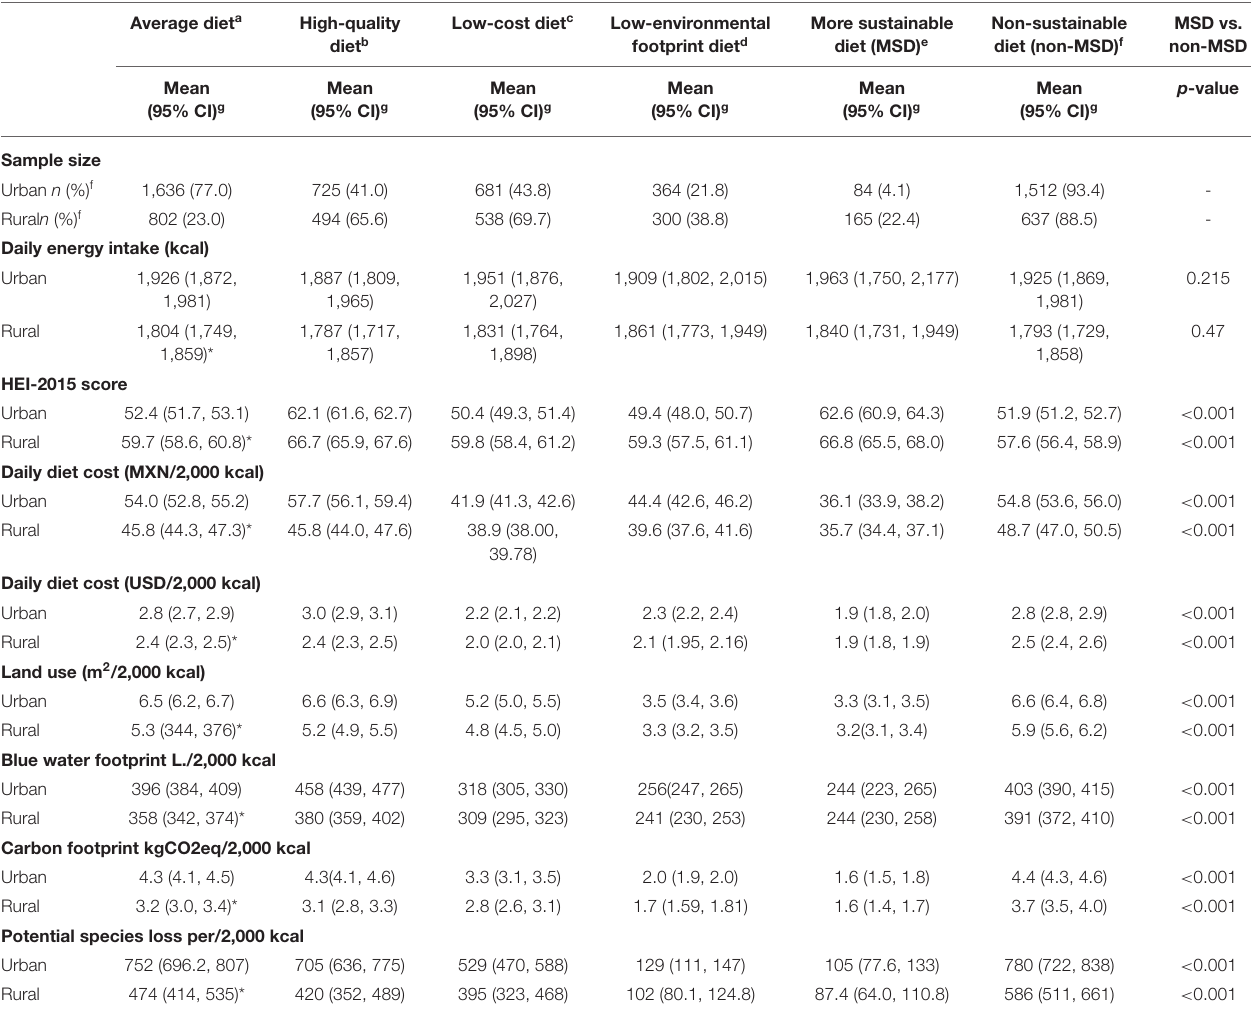
a Overall mean. b Diets with HEI-2015 above the overall median of the population (54.2). c Diets with cost below the overall median (50.9 MXN ≈ 2.6 USD). d Dietswithenvironmentalindicatorsbelowtheoverallmedian:landuse(5.5m 2 ),bluewaterfootprint(361L),carbonfootprint(3.4kgCO2eq),andbiodiversityloss(423potentialspecies loss × 10 − 10 ). e Diets that combine the criteria for high-quality, low-cost and low-environmental-footprint diets. All the groups (2–5) are non-independent. f Diets that do not meet the criteria for high-quality, low-cost and low-environmental-footprint diets. g Percentage and mean values are adjusted by the probabilistic survey design. * Indicates significant difference compared with the average diet in urban area (p < 0.05).